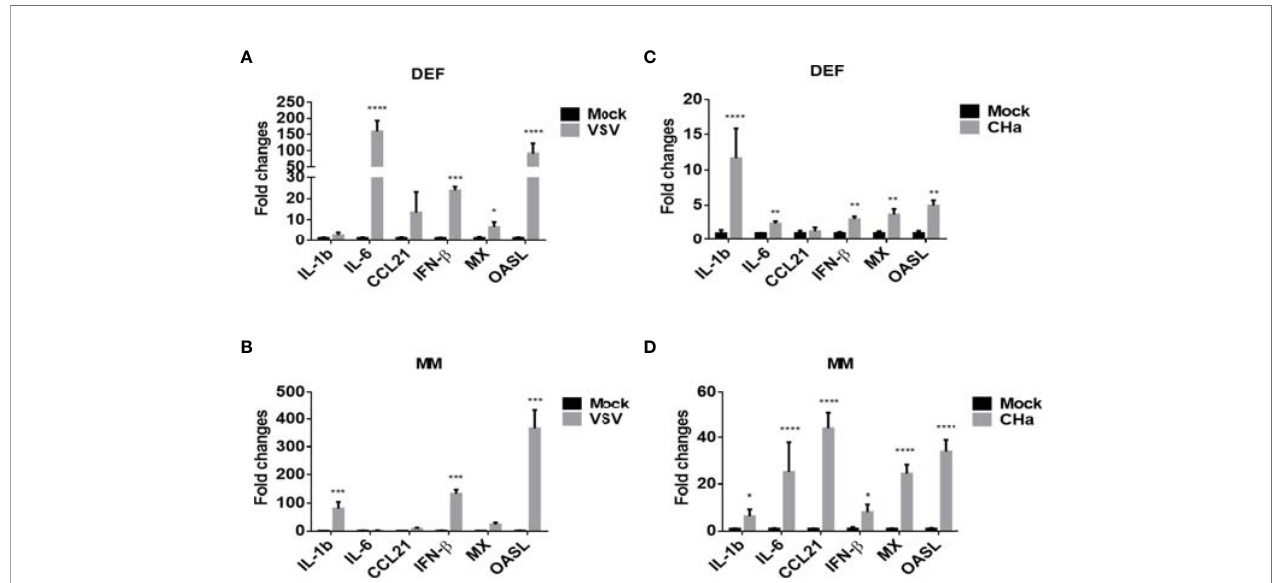
FIGURE 4 | VSV and DPV CHa strain-induced IFN, ISGs and cytokines in duck DEF and MM cells. DEF cells were infected with VSV (A) or DPV CHa strain (C) at 5 MOI for 24 h. MM cells were infected with VSV (B) or DPV CHa strain (D) at 5 MOI for 24 h. The expression level of IL-1 b , IL-6, CCL21, IFN- b , MX and OASL were tested using RT-qPCR 24 h post-treatment. The relative expression was presented as fold changes compared to mock treatment. “ * ” was considered signi fi cant difference ( p < 0.05); “ ** ” was considered highly signi fi cant difference ( p < 0.01); “ *** ” was considered highly signi fi cant difference ( p < 0.001); “ **** ” was considered highly signi fi cant difference ( p <